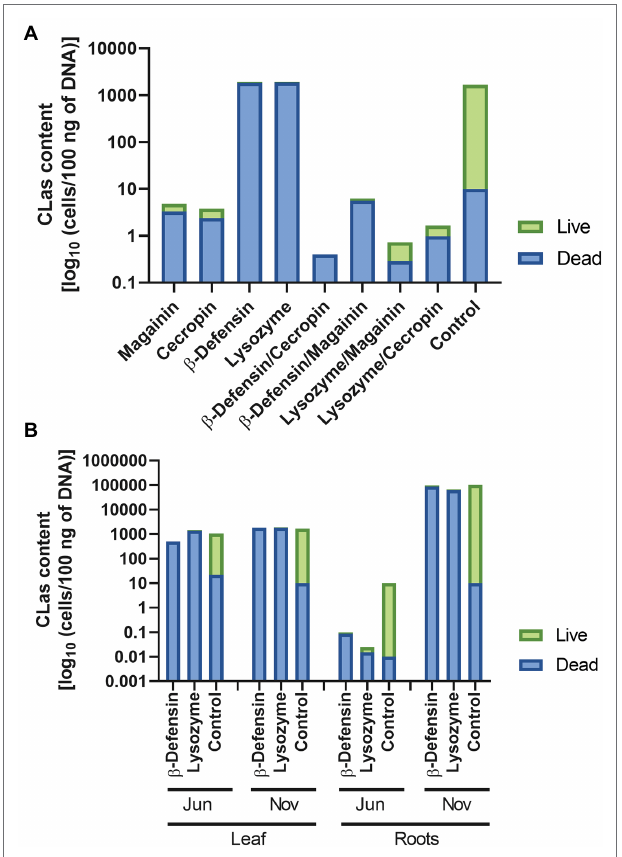
FIGURE 5 | Activity of antimicrobial peptides translocated to the vasculature in HLB-infected Citrus trees. Quantitative Real-Time calculated CLa content as log 10 (cells/100 ng of DNA). Live or dead bacteria were estimated using EMA-PCR (A) content of Candidatus Liberibacter asiaticus in Citrus trees expressing magainin, cecropin, β -defensin, lysozyme, and combinations: β -defensin/cecropin, β -defensin/magainin, lysozyme/magainin, and lysozyme/ cecropin. Control plants are untransformed, wild type Citrus trees. (B) Kinetics of selected β -defensin and lysozyme expressing plants were assayed during a year, measuring CLa levels in June and November, in both leaves and roots. Complete bars represent total bacteria content, green bar is live bacteria, and blue bar is dead bacteria